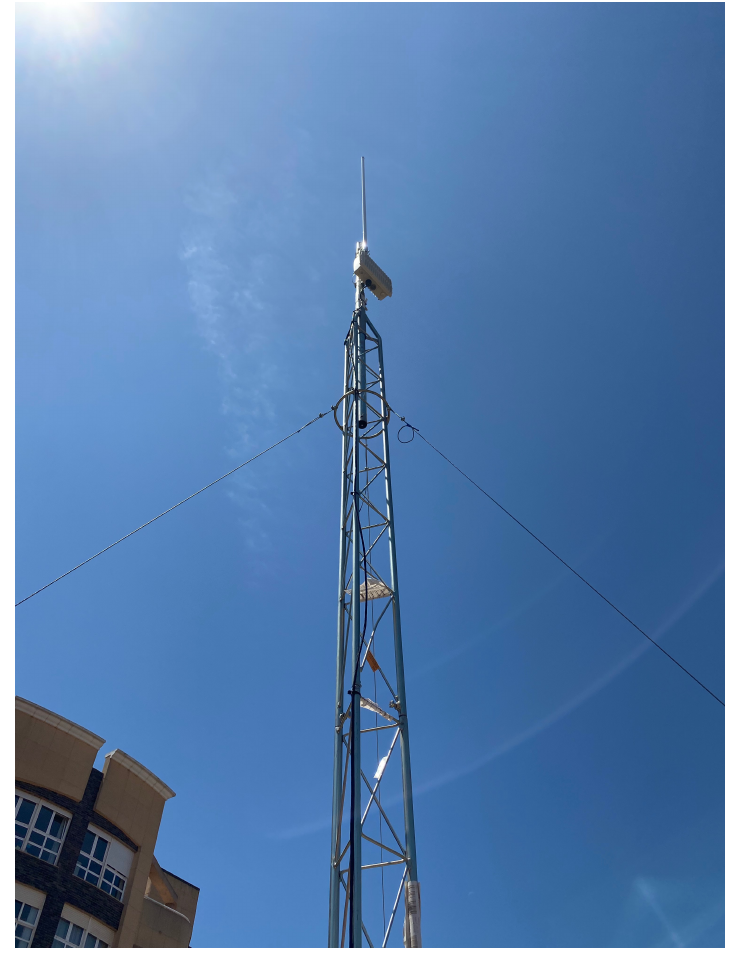
Figure 2. Antenna and